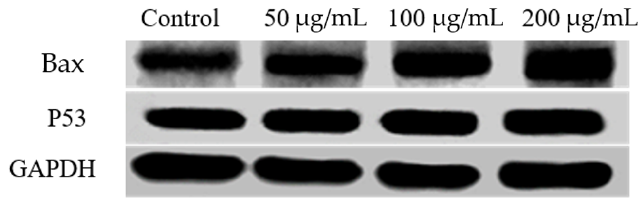
Figure 9. The effect of RLE on the expression level of apoptosis-associated protein in HT-29 cell.